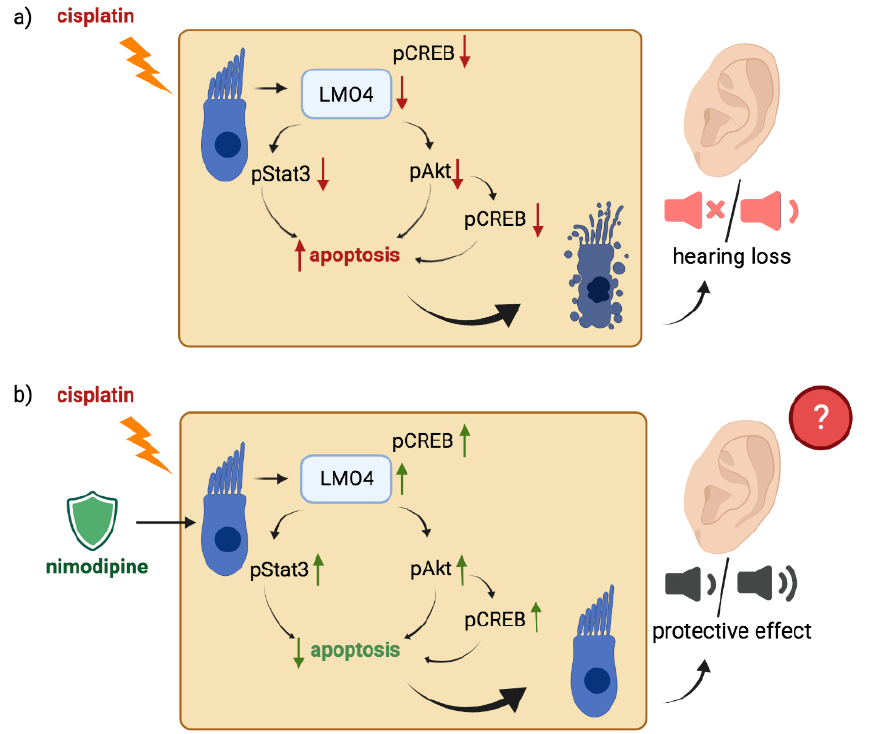
Figure 7. Nimodipine pre-treatment could protect hair cells from cisplatin-induced apoptosis via upregulation of LMO4 and anti-apoptotic pathways. Cisplatin leads to the downregulation of the transcription factor LMO4 via the production of intracellular reactive oxygen and nitrogen species. This causes an increase in apoptosis of auditory hair cells and hearing loss, one of the most common side effects of this chemotherapy, via downregulation of the anti-apoptotic cell signaling pathways ( a ). Nimodipine counteracts this process and reduces auditory hair cell death via the upregulation of LMO4 and the associated activation of Akt, CREB and Stat3 ( b ). The scheme was created with BioRender.com.